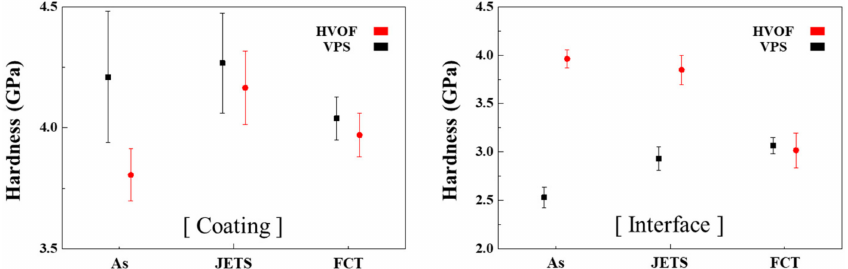
Figure 7. Vickers hardness change after FCT and JETS test for HVOF and VPS coated